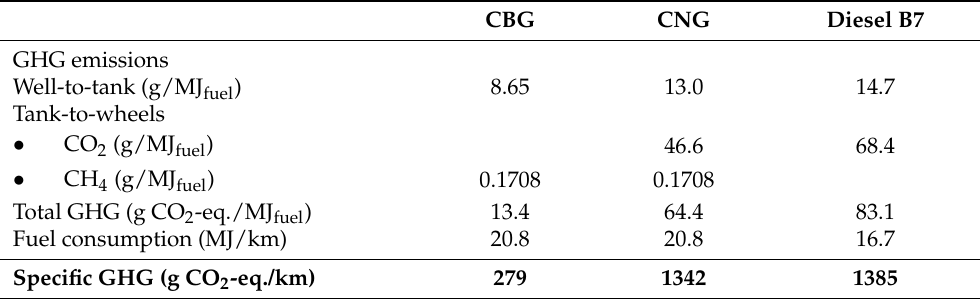
Table 7. Well-to-wheels CO 2 Equivalent emissions for CBG, CNG, and diesel B7.